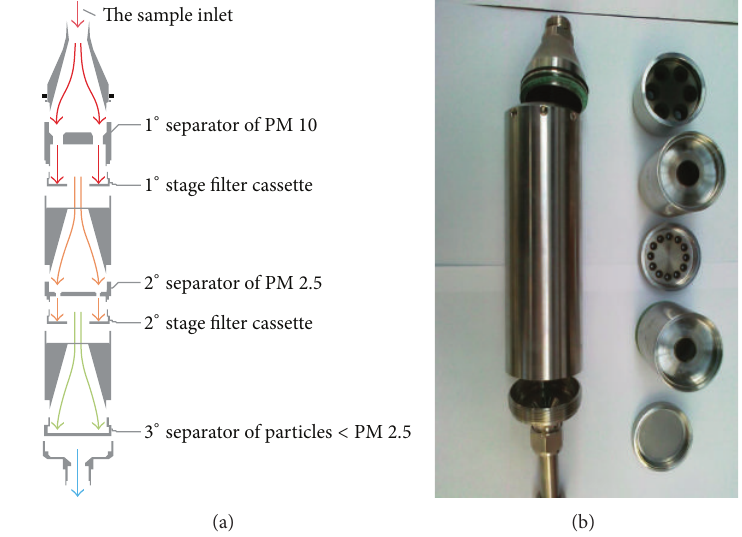
Figure 1: Multistage separation impactor.